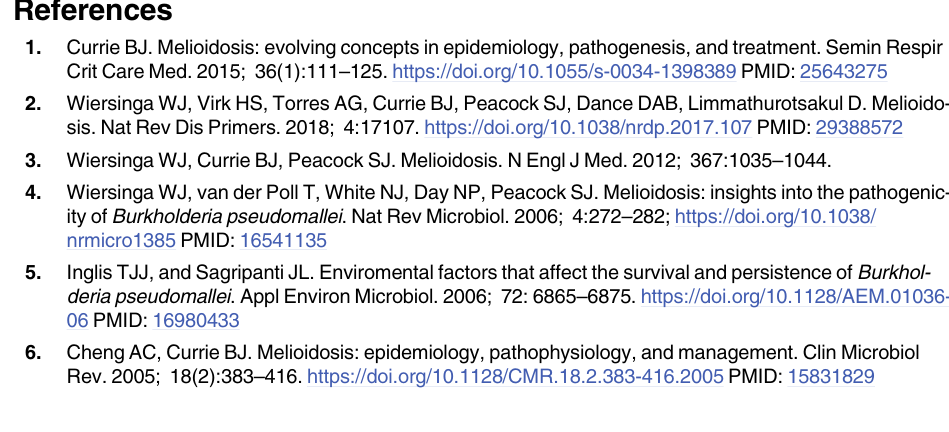
S8 Fig. Histologic brain lesions of AGM exposed to B . pseudomallei MSHR5855. (A) Brain, cerebrum, right hemisphere: Multifocal hemorrhage and cavitation with a locally extensive increase in size. (B) Cerebrum, right hemisphere: Multifocal moderate neutrophilic and histio- cytic encephalitis is marked with “d”, 2x, H&E. (C) Cerebrum, right hemisphere: Immunore- active (brown staining) inflammatory cells and necrotic debris, 2x, IHC antibody B . pseudomallei . S1 Table. Histopathologic findings in AGMs and RMs following inhalation of B . pseudo- mallei HBPUB10134a. S2 Table. Histopathological and IHC score in AGM’s target organ post-exposure to B . pseudomallei . S3 Table. Histopathological and IHC score in disseminated organs of AGM post-exposure to B . pseudomallei